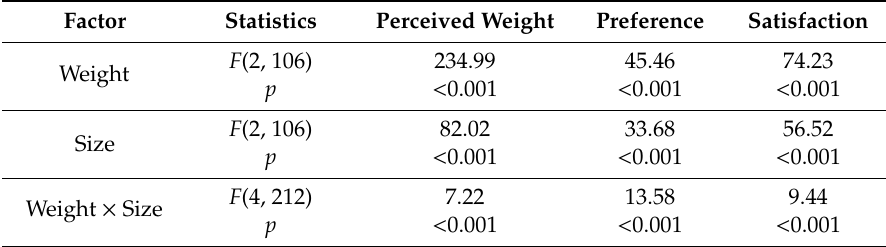
Table 3. E ff ects of size and weight of cookie